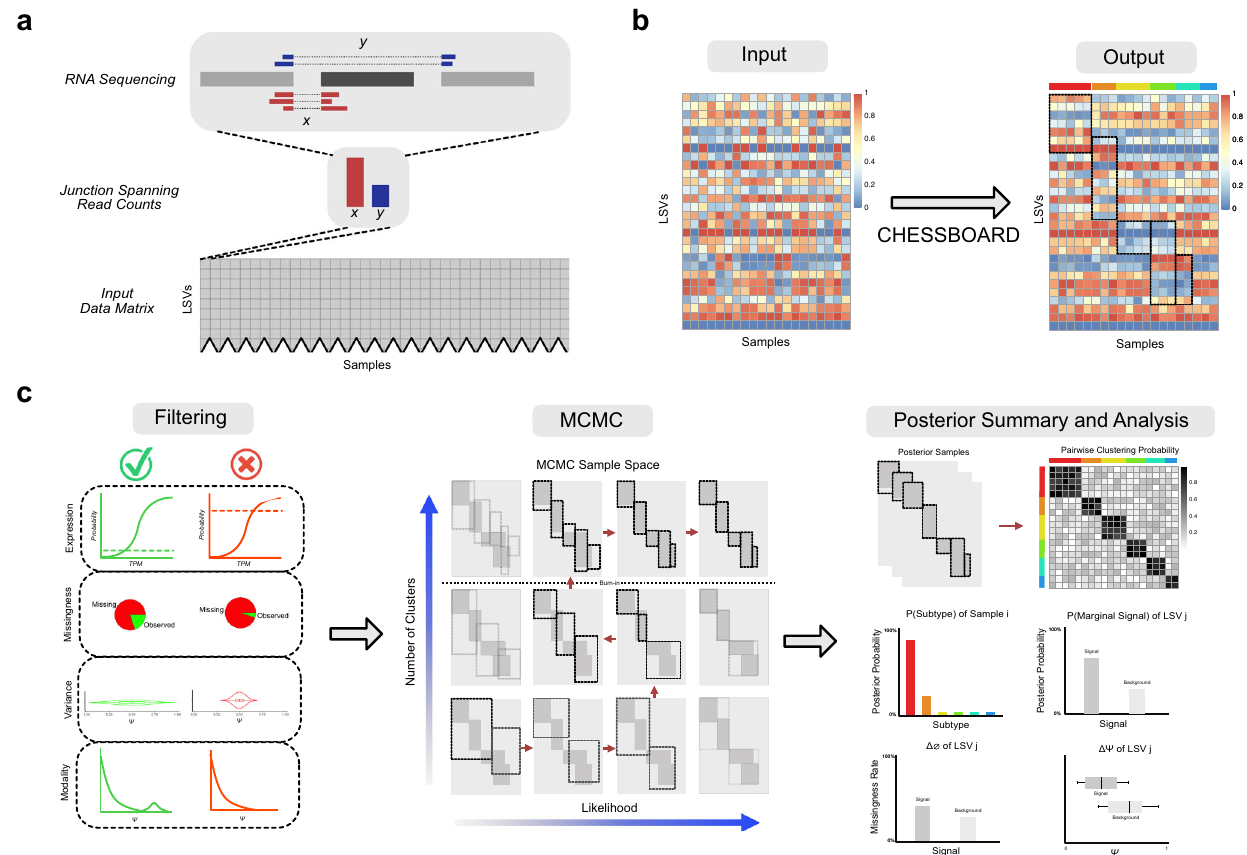
Fig. 1 | CHESSBOARD Pipeline. a Input: splice junction read counts (red and blue reads) extracted from patients' RNAsequencing. Each row inthe input data matrix is aLSV(e.g.,cassette exonshown) and each rubriccontainsthe junctionspanning read counts for that LSV in a speci fi c sample. In complex LSV involving more than two junctions, the most variable junction is selected (Methods). b Task: CHESS- BOARD ’ s objective is to identify latent tiles in the input matrix. A tile consists of a subset of samples and a subset of LSVs where the Ψ distribution of each LSV for samples within the tile differs from the background distribution. Note that the matricesshowncontain Ψ valuesforvisualizationpurposesbutCHESSBOARDacts on the matrix described in ( a ) and it may not be possible to embed each tile as a continuous square in a 2D image as shown here. c CHESSBOARD Pipeline: The